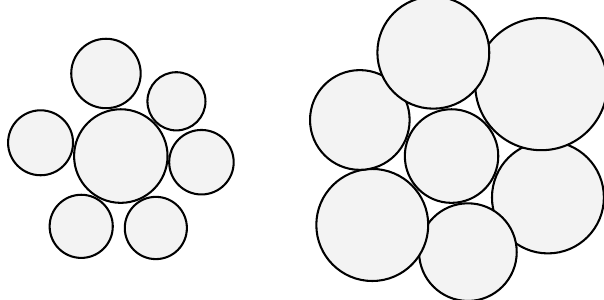
Figure 1. A main cause for intellectual dormancy in academia: Although of identical size—due to the surroundings, the central circle in the left figure seems of larger diameter than the central circle in the right figure. This optical illusion illustrates the academic delusion of inflated ego (accomplished in this example by recruiting colleagues who are less clever than one self).